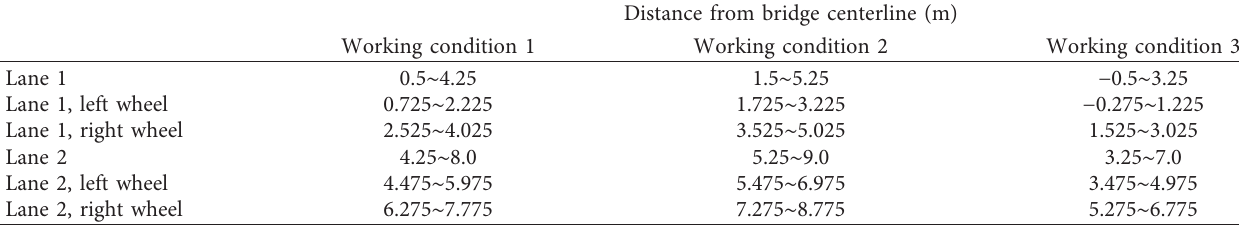
Table 8: Distribution ranges of lanes and wheels under various working conditions.